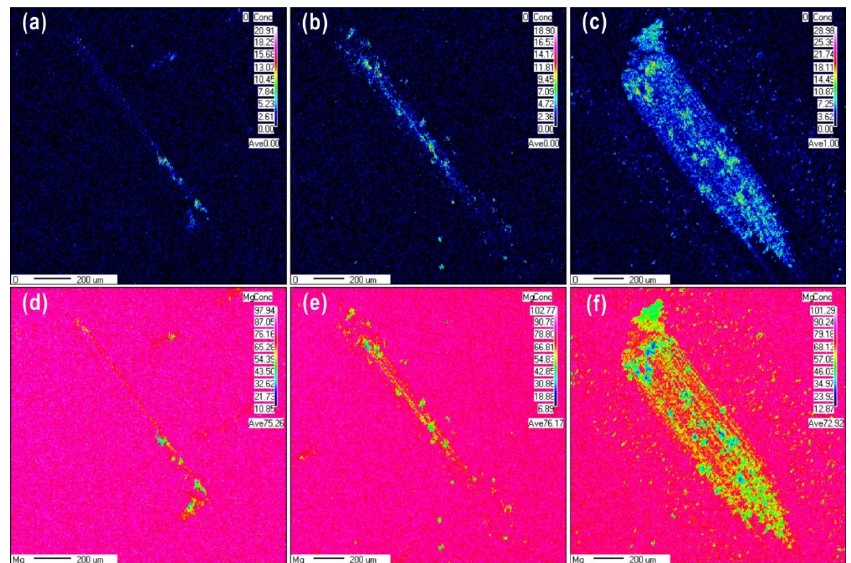
Figure 6. Electron probe micro-analyzer (EPMA) maps of Mg and O on the surface of a sample subjected to wear at a load of 0.1 N for ( a , d ) 10 cycles, ( b , e ) 100 cycles, and ( c , f ) 1000 cycles;.